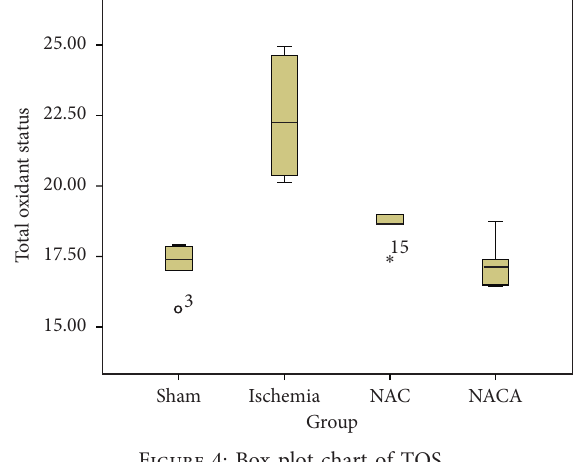
Figure 4: Box plot chart of TOS.